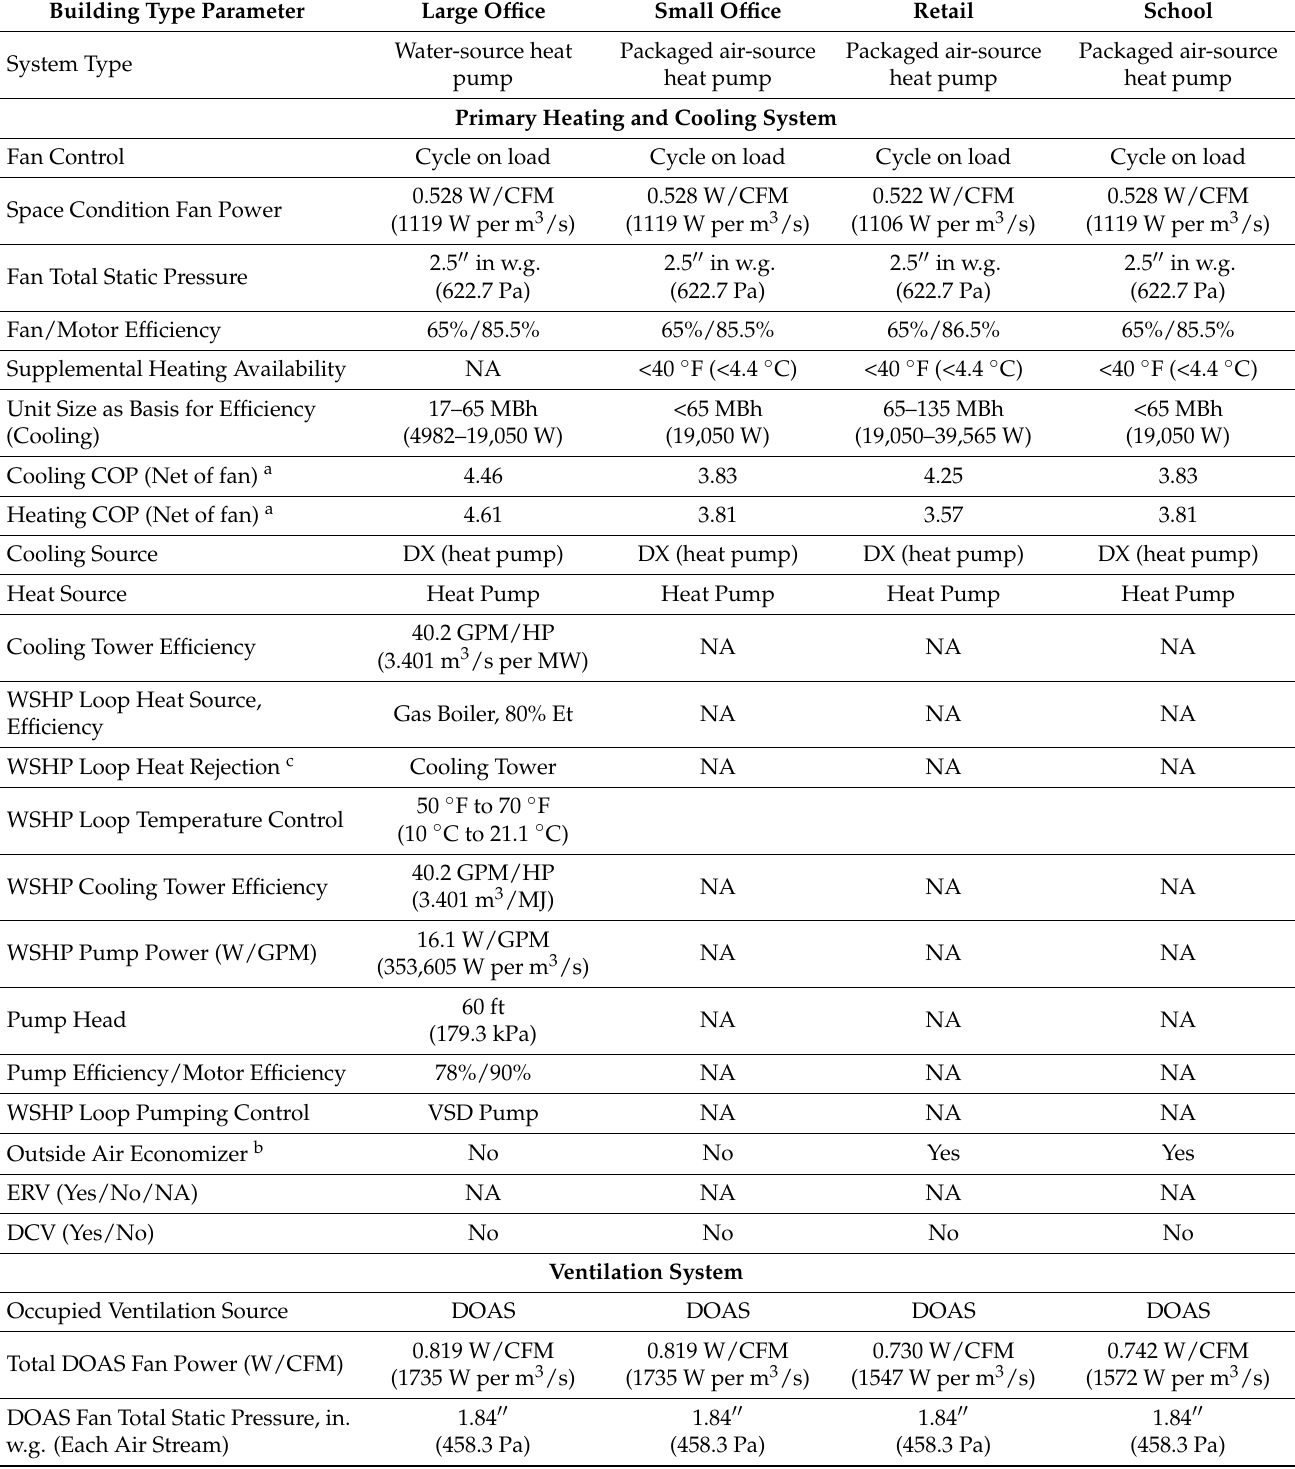
Table 2. WSEC specifications for baseline HVAC systems (WSEC